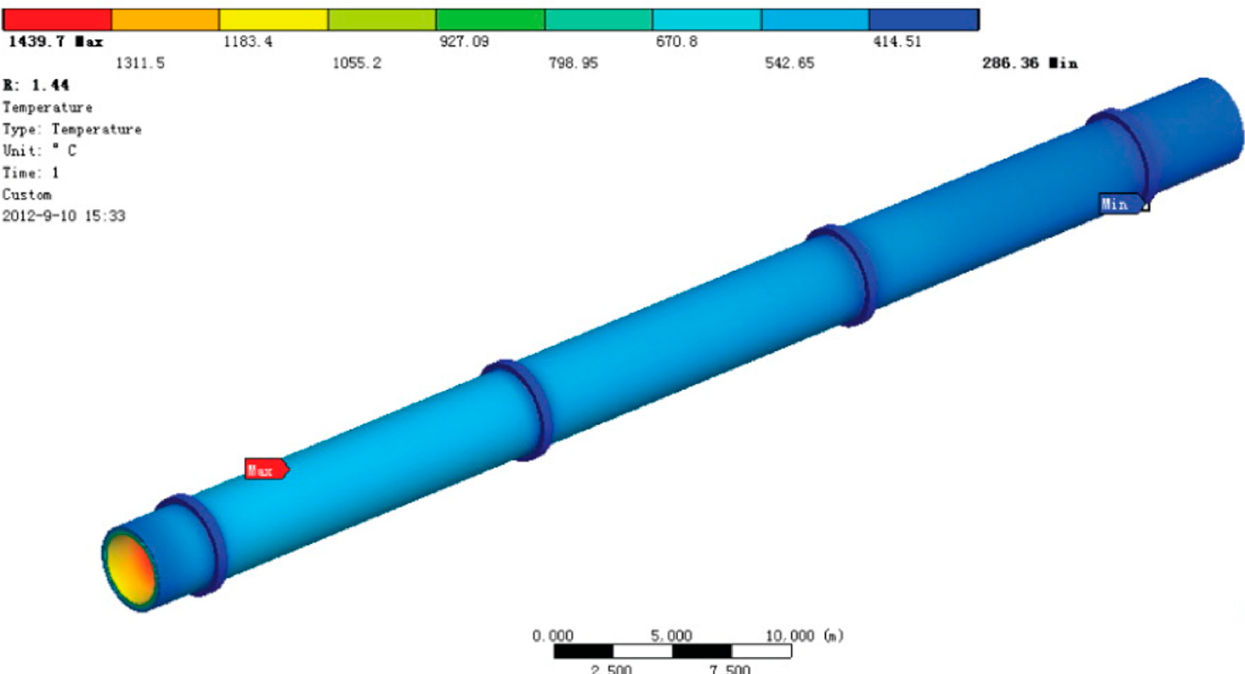
Figure 13. Thermal profile of a cement rotary kiln outer surface.